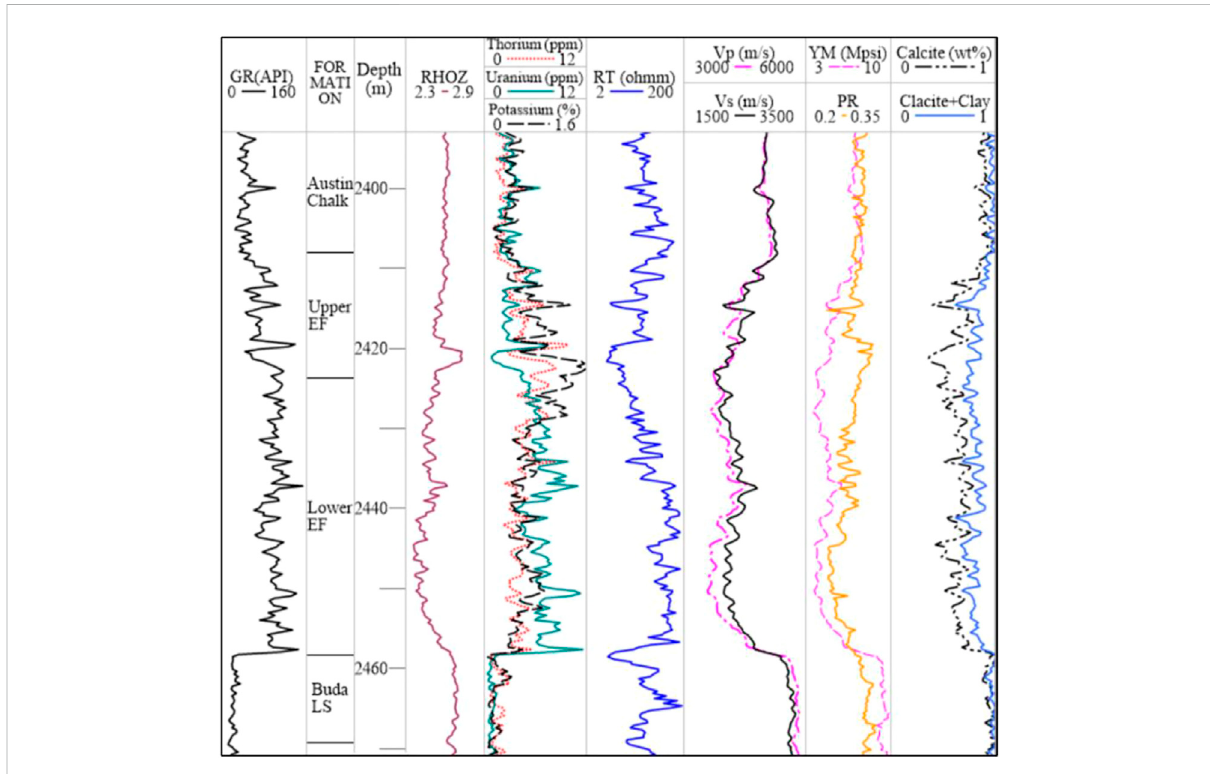
FIGURE 9 Well logs of a well in LaSalle County, showing the Eagle Ford shale and the adjacent formation